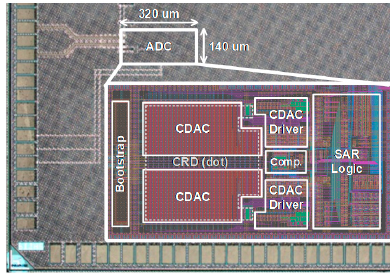
Figure 16. Die photograph.